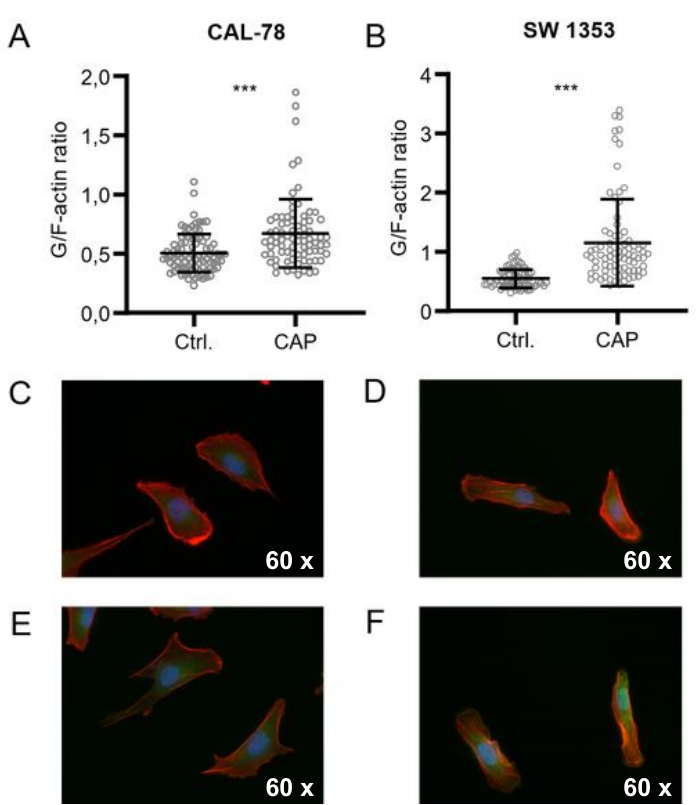
Figure 5. CAP treatment destroys the integrity of the cell membrane. G-/F-actin assay CAL-78 ( A , C , E ) and SW1353 ( B , D , F ) cells were seeded on cover slides and incubated over 24 h. After incubation, cells were treated with 5 (CAL-78) and 10 s (SW1353) CAP or carrier gas argon. Cells were dyed with tetramethylrhodamine (TRITC) conjugated Phalloidin and Alexa Fluor 488-conjugated deoxyribonuclease I, and fluorescence was recorded with a BZ-9000 microscope and analyzed with a BZ-II Analyzer (KEYENCE, Neu-Isenburg, Germany). The ratio of the red signal compared to the green signal of each cell was calculated. Data are given as mean ± SD; significant differences are indicated as follows: * p ≤ 0.05